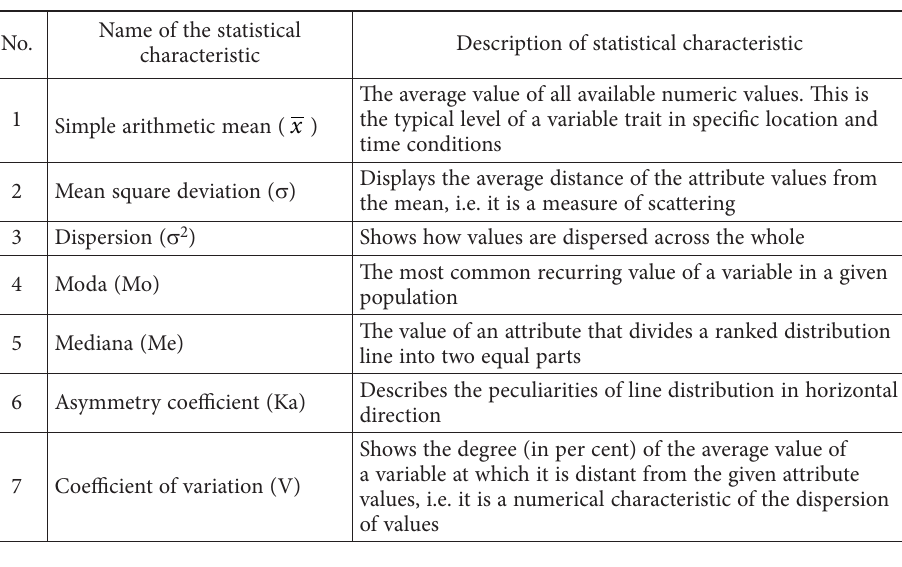
Table 9. Intervals of economic development indicators of Polish and Lithuanian regions (source: com- piled by authors)